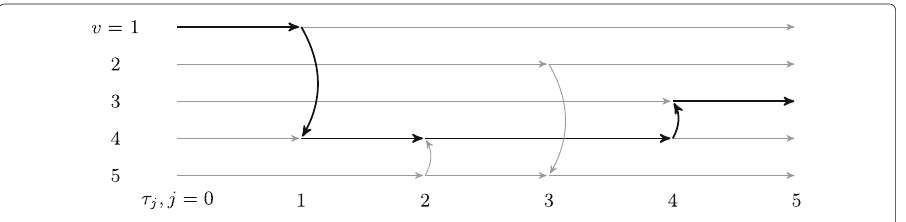
Fig. 1 Temporal digraph of the DCN C : = { ( 1,4, τ 1 ) , ( 5,4, τ 2 ) , ( 2,5, τ 3 ) , ( 4,3, τ 4 ) } with τ 1 < τ 2 < τ 3 < τ 4 . We indicate a temporally coherent path from C -vertices 1 to 3 with bold versus gray arrows: note that there is no temporally coherent path from 2 to 3. In the figure, spatial (respectively, temporal) arcs are vertical (horizontal). The vertices along a horizontal path constitute the temporal fiber C @ v for v